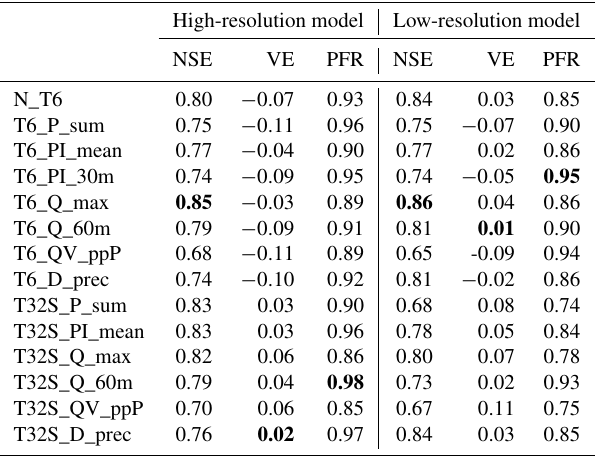
Table 4. Calibration results. Bold font indicates the best value in each